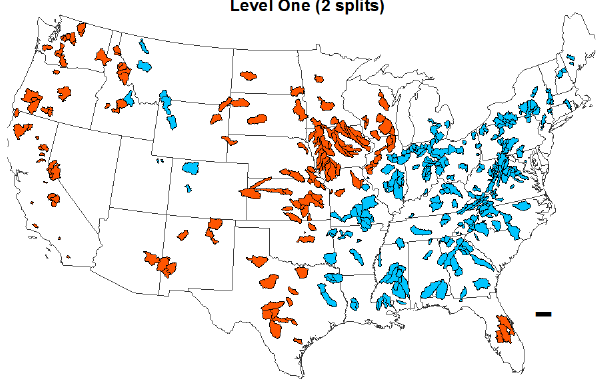
Fig. 8. Second split: low seasonality and earlier precipitation peak (dark blue), low seasonality and later precipitation peak (light blue), higher seasonality and non-arid (yellow), higher seasonality and arid